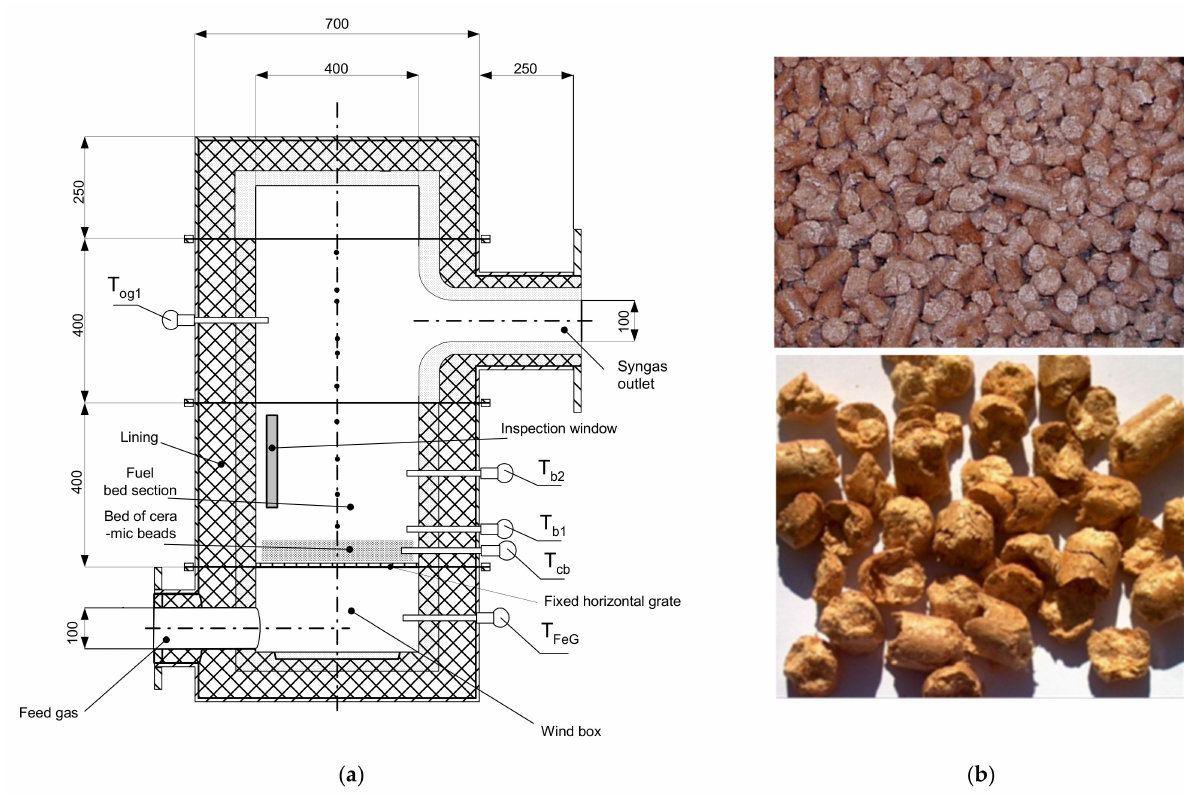
Figure 2. ( a ) Side view of batch type, counter-current and updraft fixed bed gasifier (H: 1800 mm, D: 400 mm) for analysis of biomass components and other combustible issues; ( b ) wood